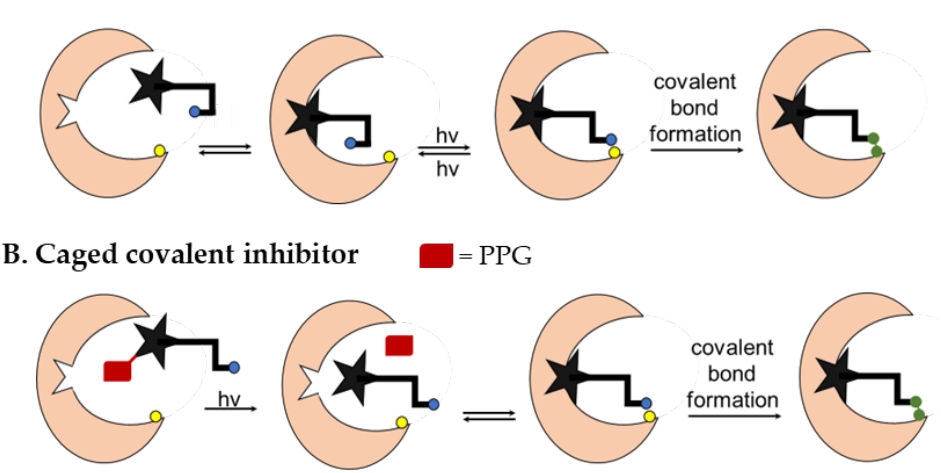
Figure 2. Principles of photoswitching ( A ) and photocaging ( B ) in the case of covalent inhibitors.